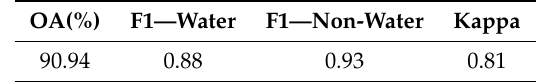
Figure 9. Some typical cases of misclassified water regions. Table 8. Results of water map assessment with inspection data.